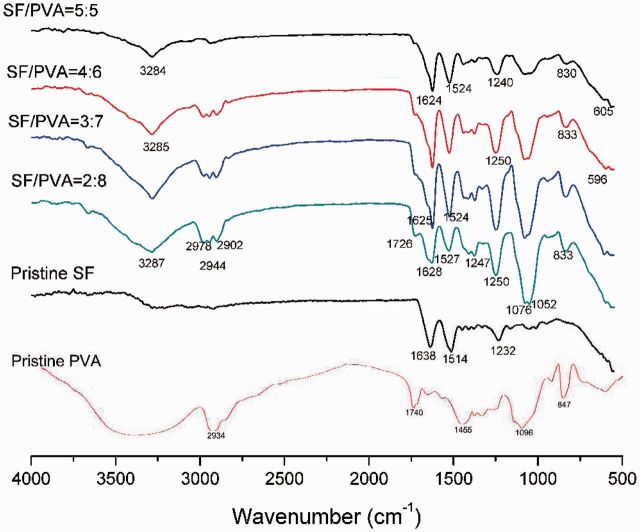
FT-IR spectra of the SF/PVA blend scaffolds and pristine SF and PVA powders